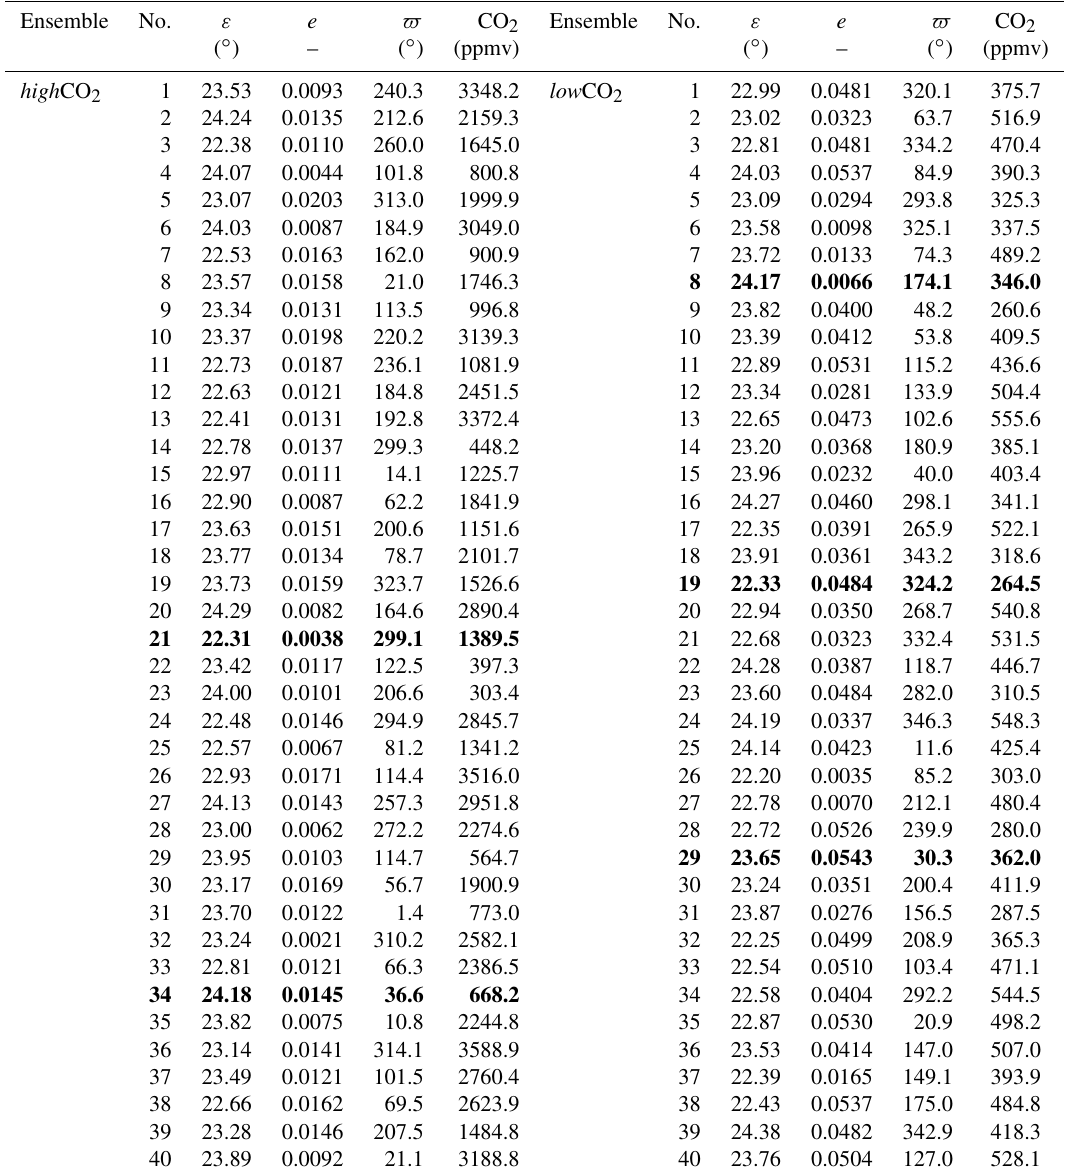
Table 2. Experiment set-up: orbital parameters (obliquity, eccentricity and longitude of perihelion) and atmospheric CO 2 concentration for simulations in the high CO 2 and low CO 2 ensembles. All experiments in both ensembles were run with modern ice sheet ( modice ) configurations. Experiments shown in bold were also run with reduced ice sheet ( lowice ) configurations. The experiment number is given, and the experiment name is constructed using the ice sheet configuration, the ensemble name and the experiment number, for example,